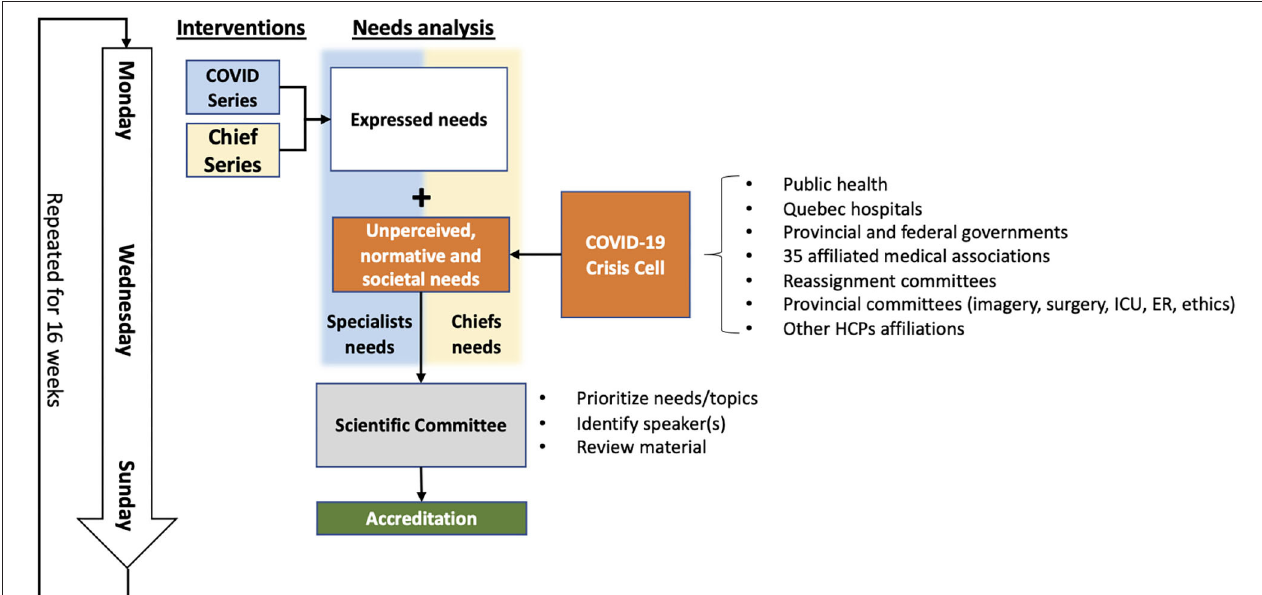
FIGURE 1 | Flowchart of weekly webinar organization. ICU, intensive care unit; ER, emergency room; HCP, healthcare professional.